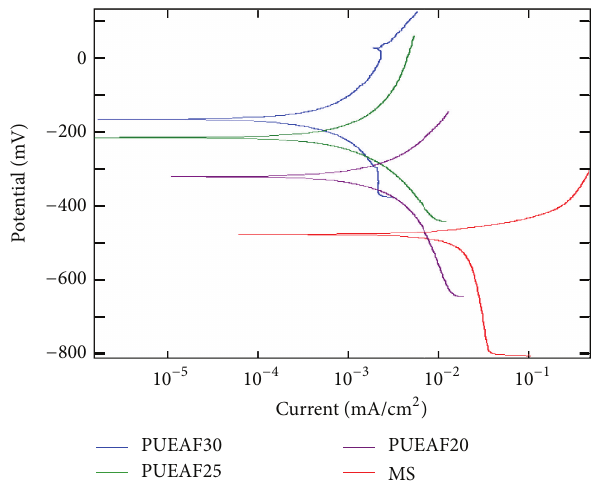
Figure 7: Tafel plots of bare MS and PUEAF coated MS in tap water.